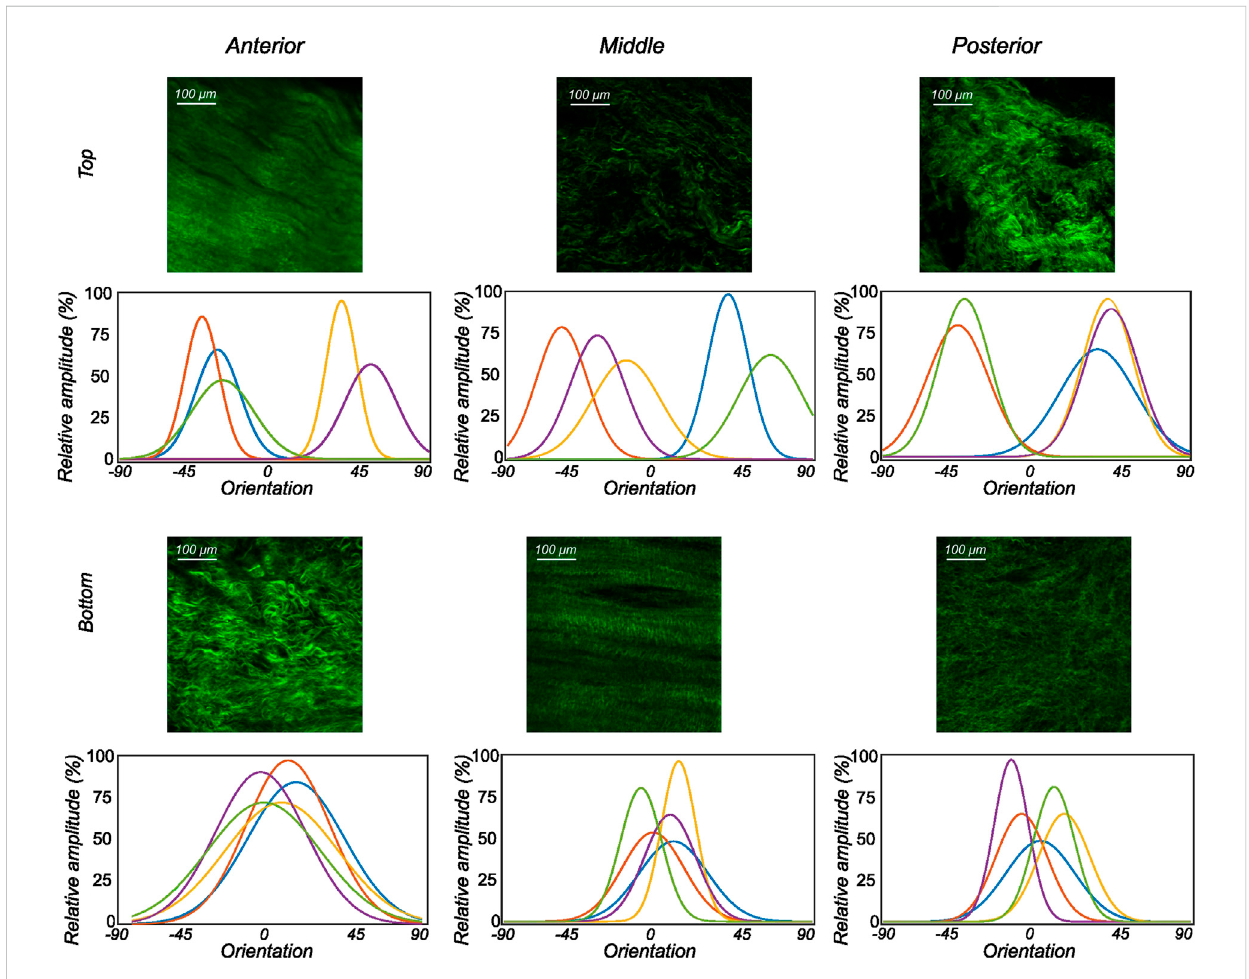
FIGURE 6 The orientation distribution computed on each image slice of individual image stacks was averaged through the thickness to obtain the representative collagen orientation distribution of the sample. Here, the computed orientation distribution for samples excised from lateral menisci is shown. The top and bottom pro fi les represent the samples from the top and bottom samples, respectively. Column-wise, they represent the anterior, mid-body, and posterior